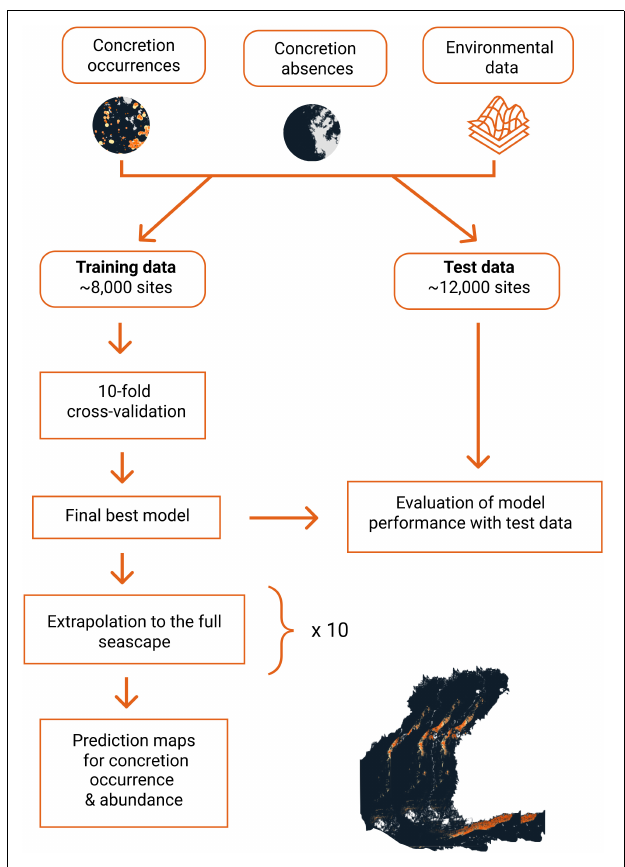
FIGURE 1 | Schematic figure of the modeling approach. The same process was repeated for all of the four models on relative concretion coverages, and the concretion abundance